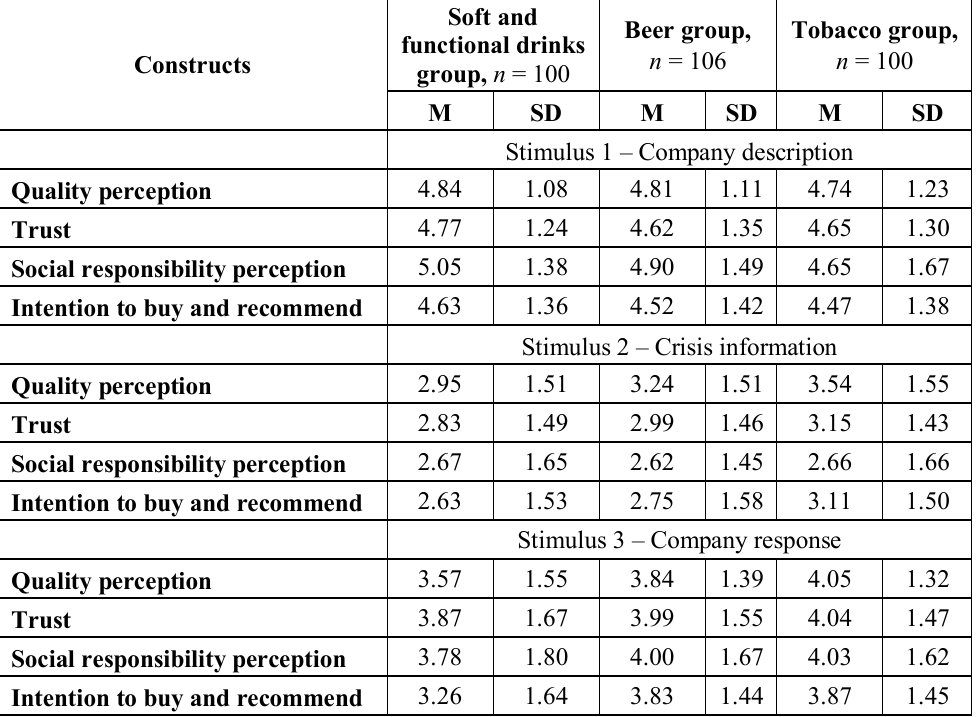
Table 2. Means and standard deviations in different experiment groups Constructs